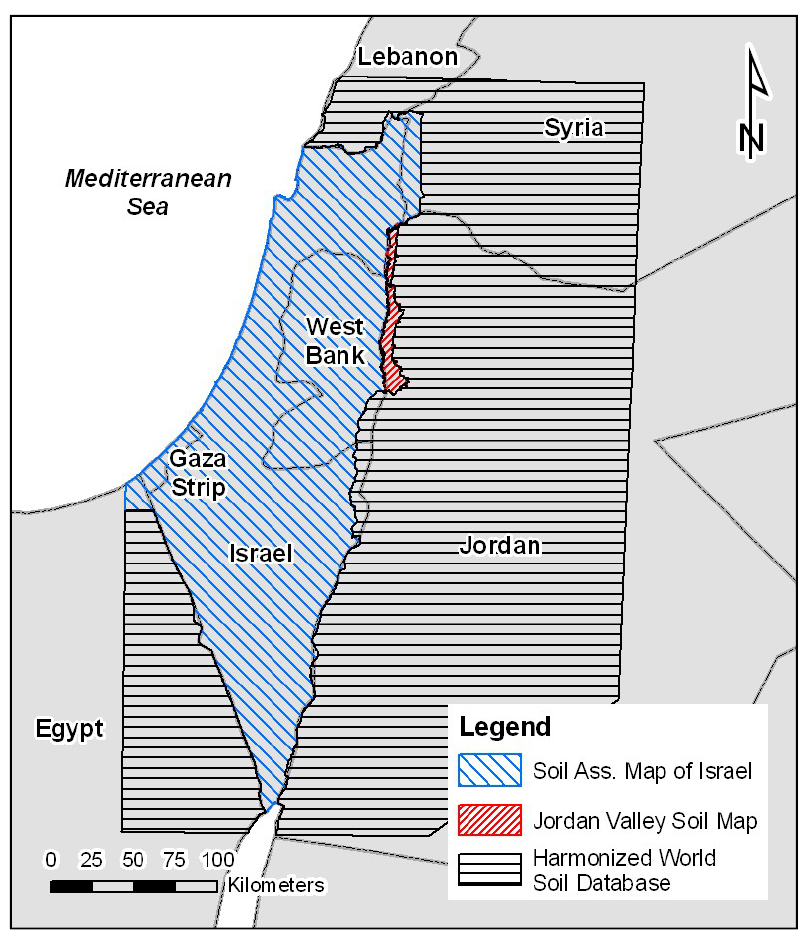
Figure 1. Coverage of the different soil information resources and the risk